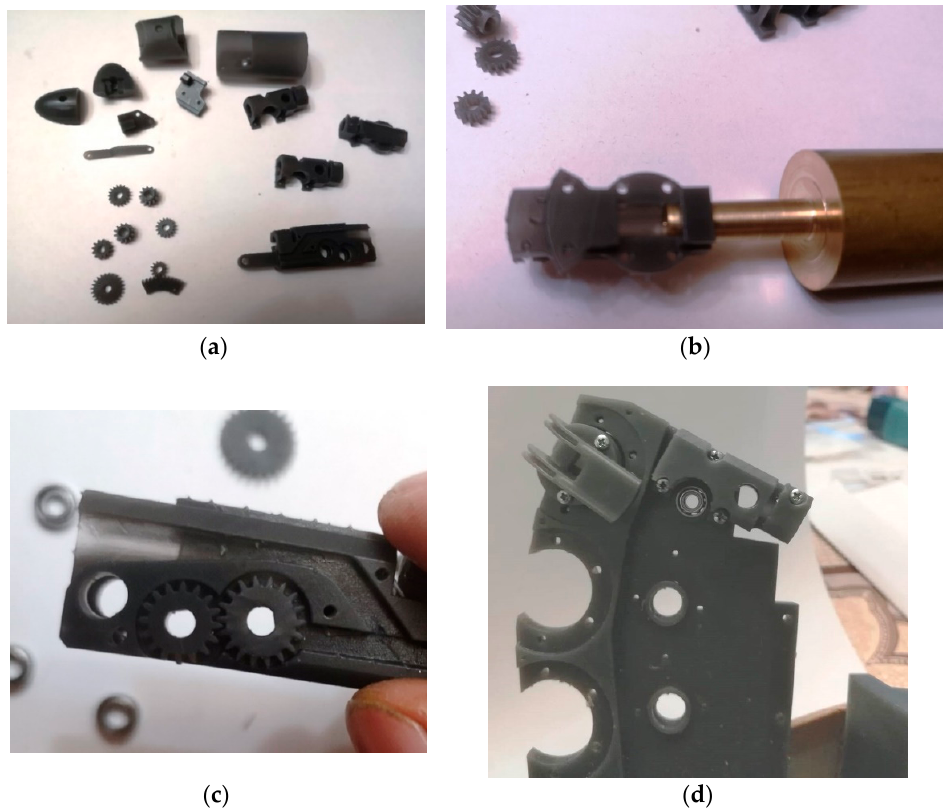
Figure 25. Checking the geometric precision of the DLP printed parts. ( a ) Printed parts, ( b ) plug gauge check, ( c ) correct gear assembly for motion transmission, ( d ) bearings mounted.